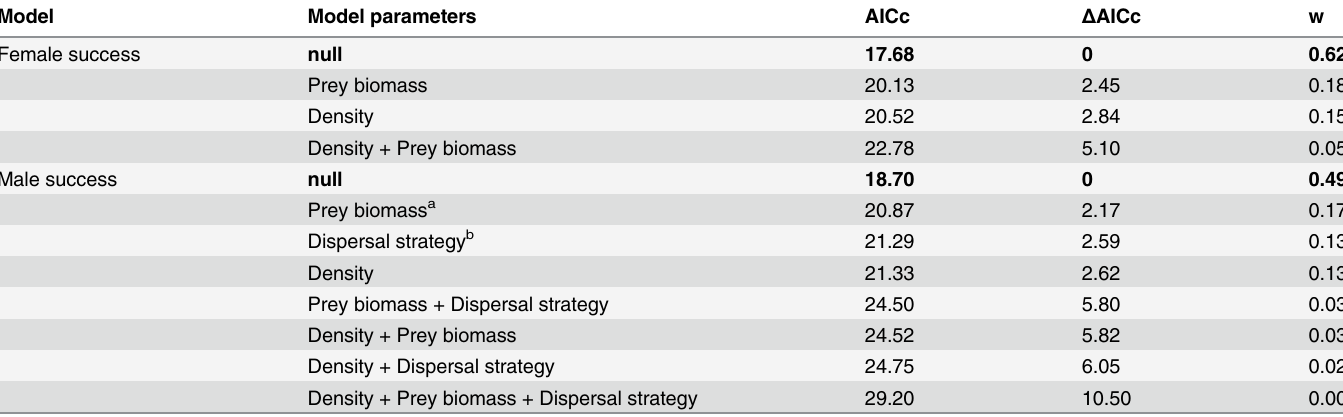
Table 5. A priori binomial regression models exploring the effect of time as a proxy for population density and prey biomass density on the suc- cess of dispersal in known-fate subadult leopards in Phinda Private Game Reserve, South Africa, 2002 –